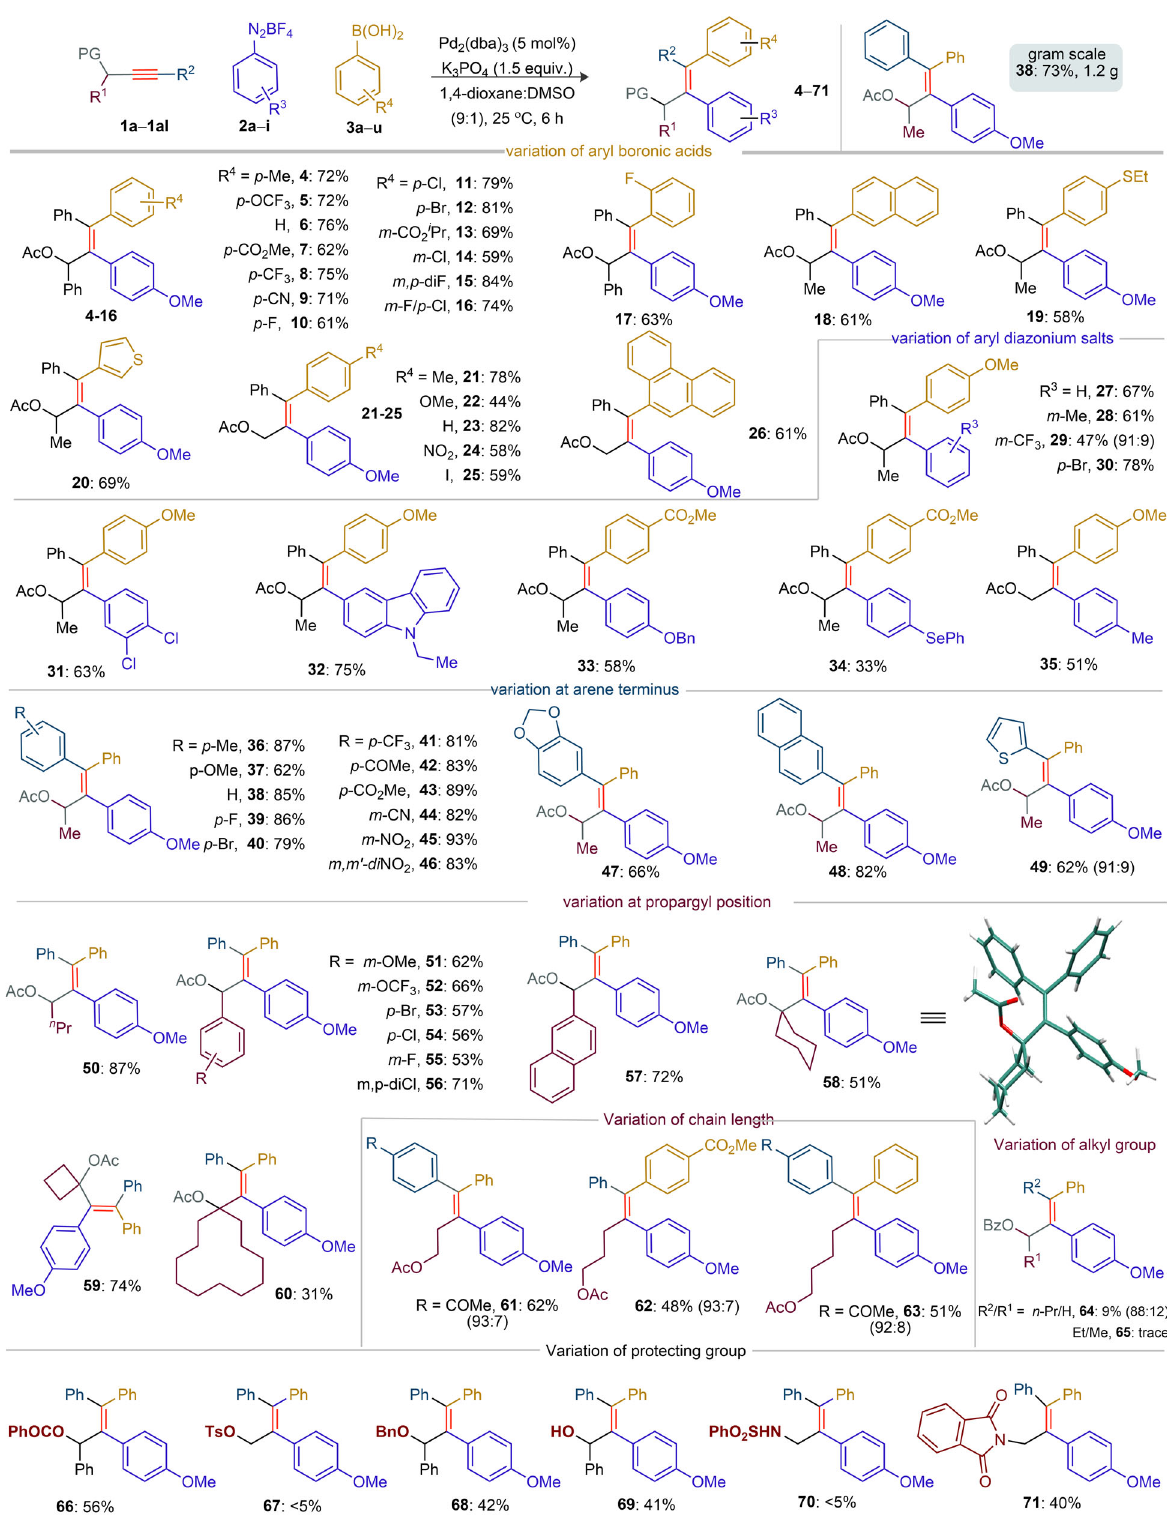
Fig. 3 Scope of alkynes, aryl boronic acids, and aryl diazonium salts a . All yields correspond to products isolated as a single stereo- and regioisomer, unless otherwise stated. a 1 (0.3 mmol), 2 (0.9 mmol), 3 (0.45 mmol). Ac acetyl and Bz